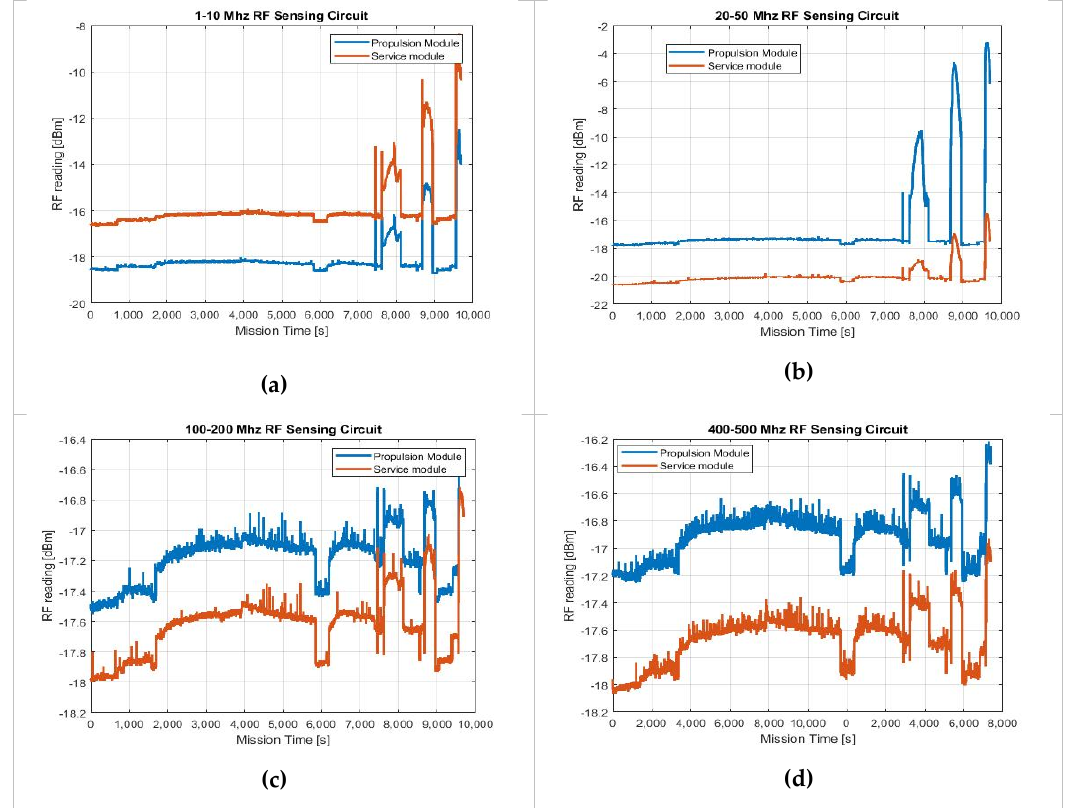
Figure 14. Radiated emissions: ( a ) 1–10 MHz, ( b ) 20–50 MHz, ( c ) 100–200 MHz, ( d ) 400–500 MHz.